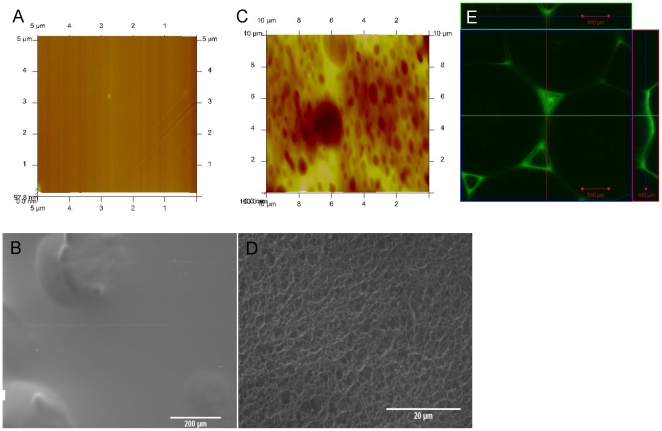
Surface nanoporous film layer.AFM and SEM images of a–b) solvent cast PLLA film and c–d) nanoporous top layer. A defined surface was obtained with both methods on top of Titanium/PLLA hybrid system. e) Confocal images of PLLA solvent casted on empty Titanium scaffolds. Solvent casting results in uniform PLLA distribution between the bead while the top layer follows the contour of the beads, whereas after freeze-extraction and film formation; a thin layer of polymer (∼4 µm) was on top of a body of porous PLLA covering the titanium beads.